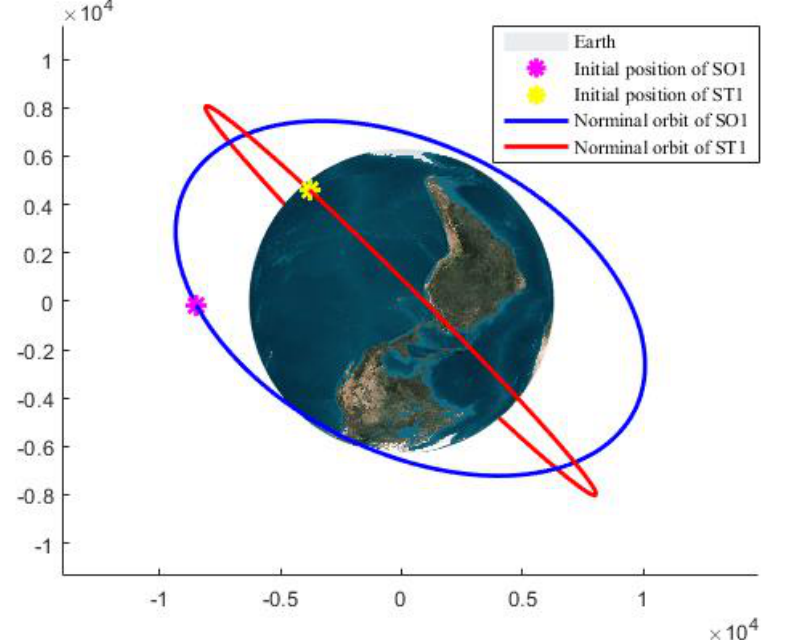
Figure 2. Orbits in general orbit configuration case.